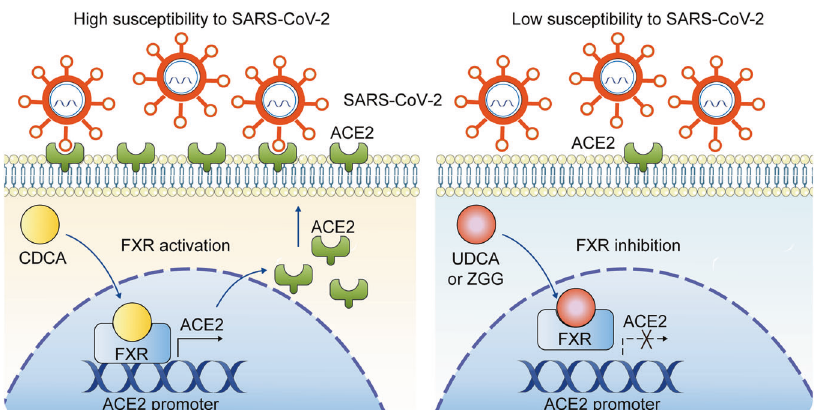
Fig. 1 The schematic diagram of FXR signaling controlling ACE2 expression. Left, CDCA binds to and activates FXR, which further induces ACE2 expression. Right, FXR inhibitors, including UDCA and the ZGG, diminish ACE2 expression and thereby reduce the susceptibility to SARS-CoV-2